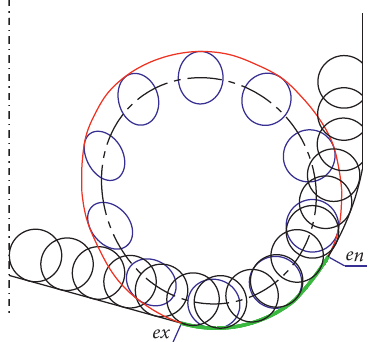
Figure 4: Covering graph of the